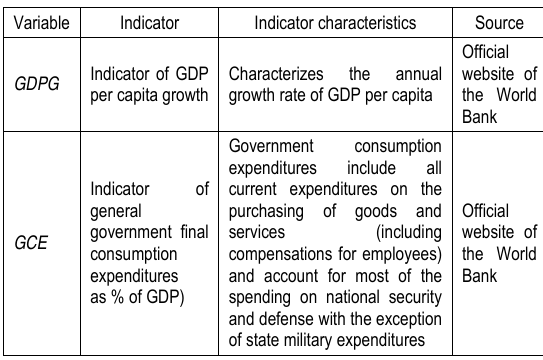
Table 3. A factor loading matrix of principal